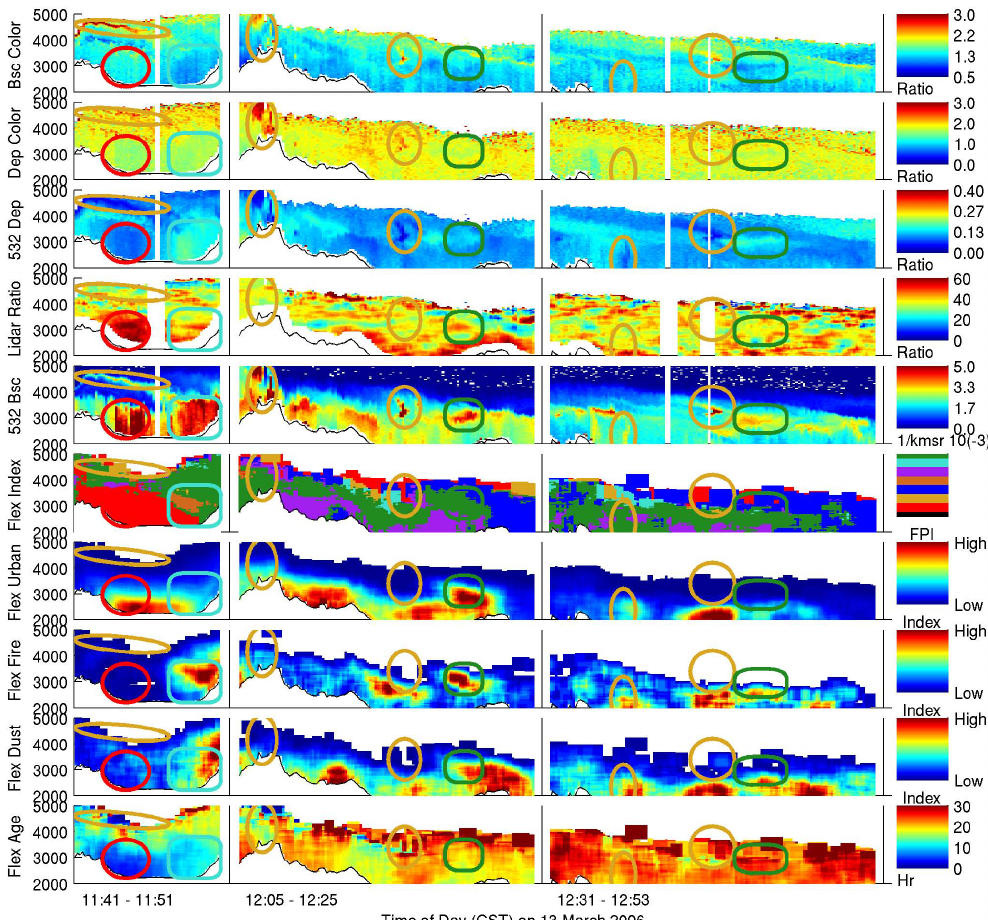
Fig. 8. Curtain plots of HSRL backscatter coefficients and intensive properties for three transects on 13 March along with Flexpart average age and particle count index for dust, fire and urban emissions. See Fig. 12 for Flexpart Particle Index (FPI) legend. The yellow ellipses show biomass burning plumes, the red ellipse shows the urban plume, the turquoise rectangle shows a biomass burning and dust mix and the green ellipses show mixed plumes. The y-axis is height above mean sea level. All transects are shown from west to east. From left to right the transects correspond to the trajectories from north to south in Fig.